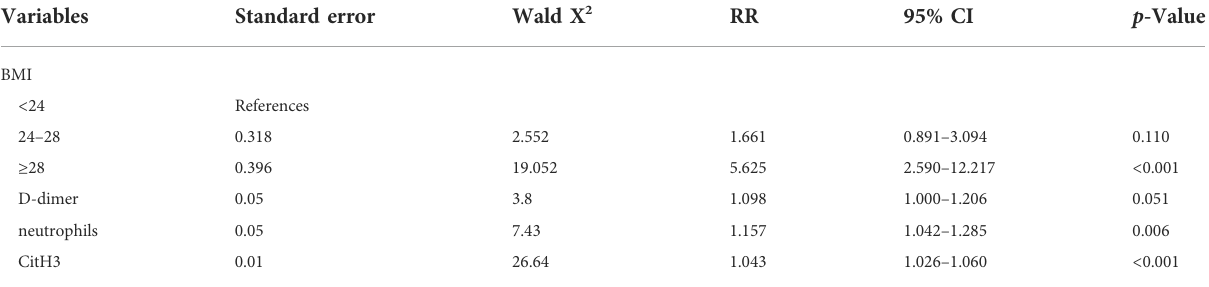
TABLE 2 Multivariate logistic regression analyses of risk factors for predicting postoperative